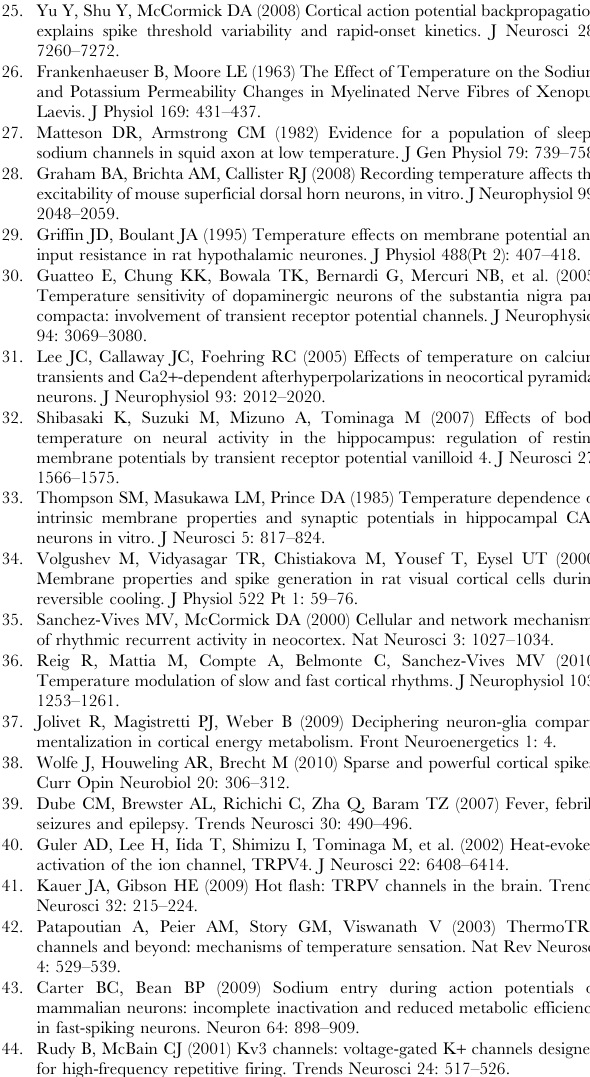
a HH model neuron (A) and the resulting effect on total Na + charge entry in response to a DC pulse (B). (TIF) Figure S5 Increases in Na + entry owing to changes in apparent input resistance and membrane time constant in a model neuron. A. Increasing specific membrane resistance from 20,000 to 60,000 only slightly decreases the excess Na + entry ratio. B, C. Example action potentials with a specific membrane resistance of 18,000 and 66,000 Ohms. D, Relationship between membrane time constant and input resistance in the model. E. Excess Na + entry ratio decreases only slightly by increasing membrane time constant. F. Firing rate of the neuron to a constant current pulse exhibits a small increase with a large increase input resistance.